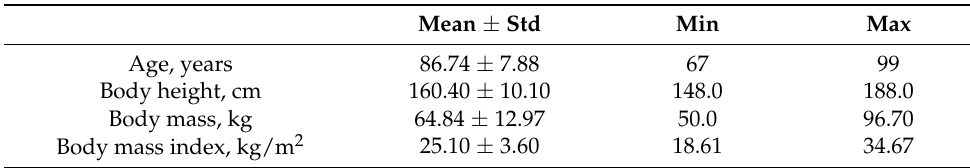
Table 1. Descriptive statistics of the 23 participants (22 females).